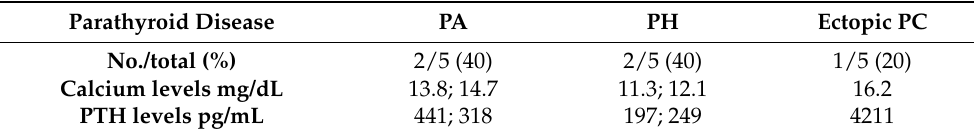
Table 2. Parathyroid diseases associated to PC. Parathyroid